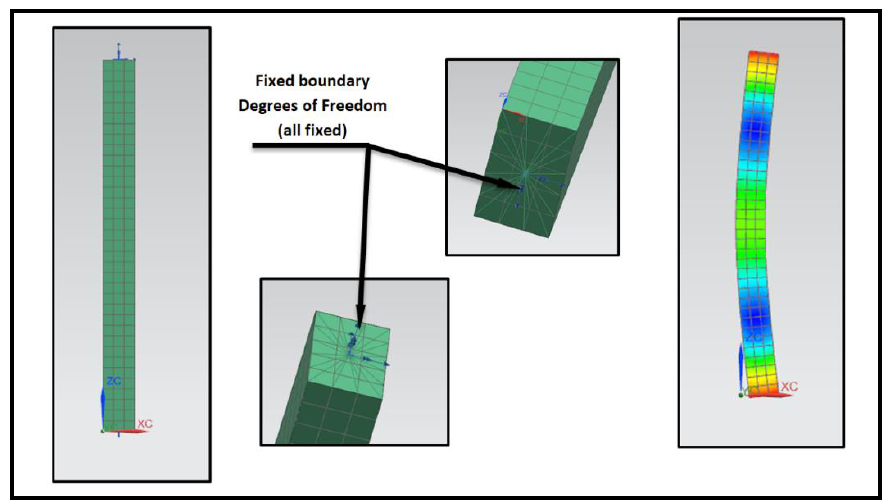
Figure 7. FEM model, the adopted boundary conditions and the first form of vibration of the supporting column [33].